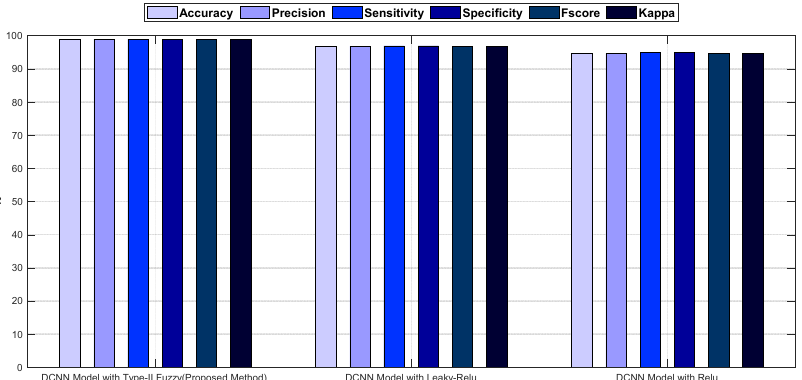
Figure 8. The bar chart diagrams of accuracy, precision, sensitivity, specificity, kappa, and f-score for the proposed method, compared to the DCNN model with Relu and Leaky-Relu activation functions.